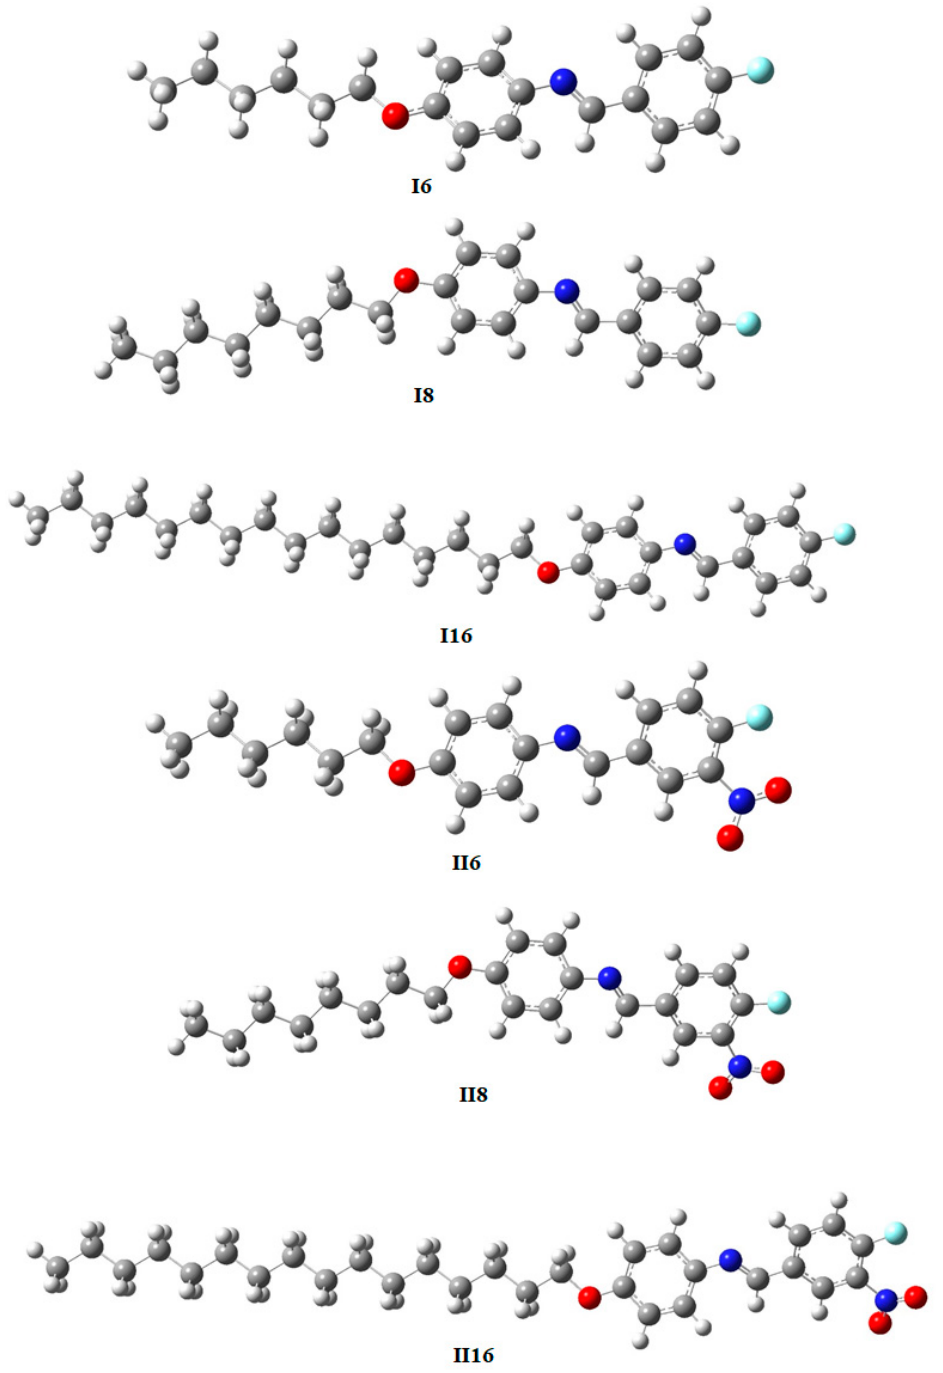
Figure 4. Optimized structures of molecules of the investigated homologues series I n and II n , calculated at the B3LYP/6- 311G** level.